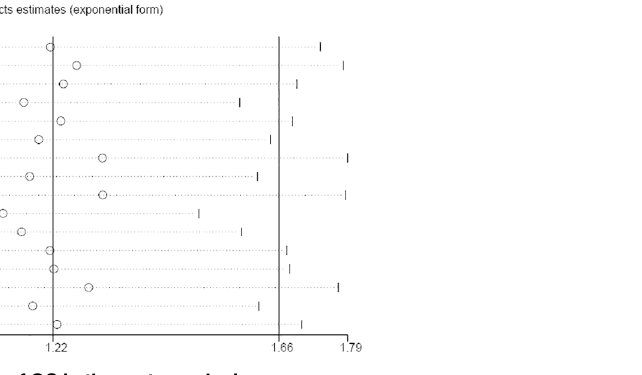
Fig 5. Sensitivity analysis of OS in the meta-analysis.